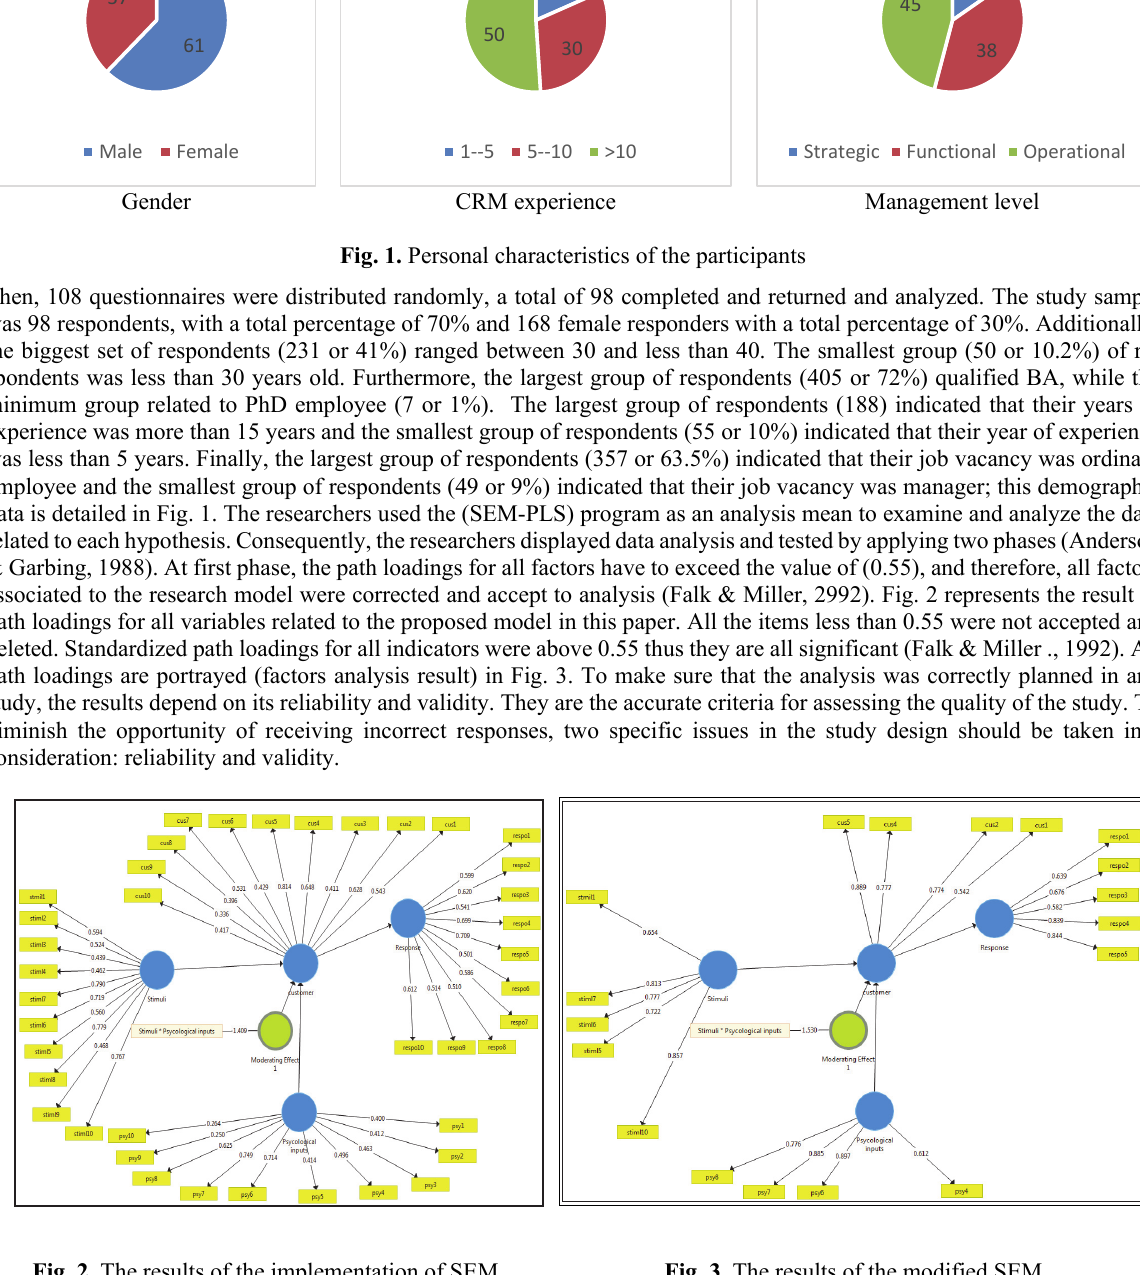
Fig. 2. The results of the implementation of SEM Fig. 3. The results of the modified